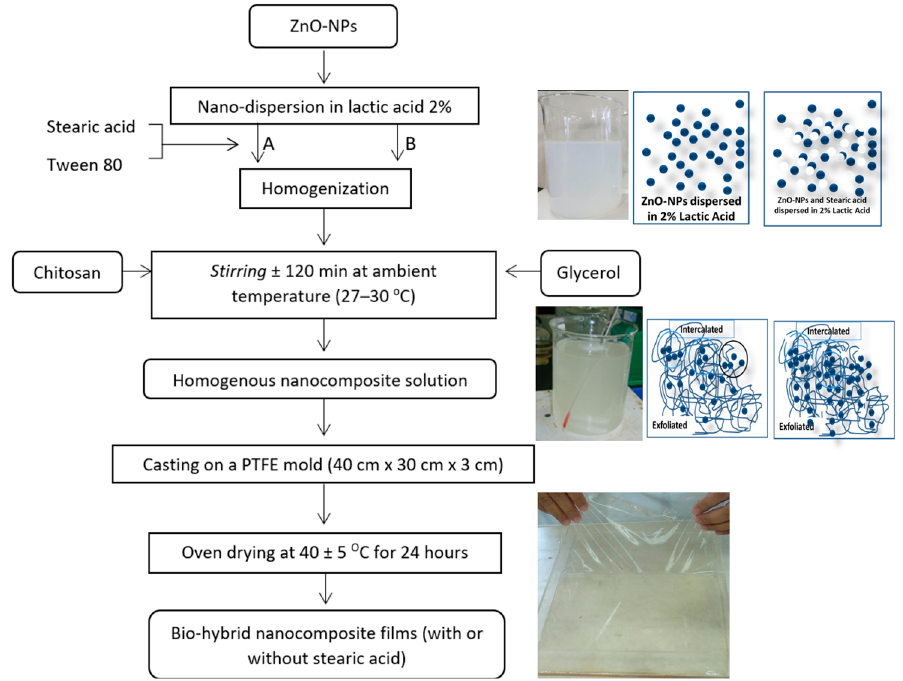
Figure 1. Flowchart of chitosan–ZnO-NPs nanocomposite film preparation: (A) with stearic acid, (B) without stearic acid.